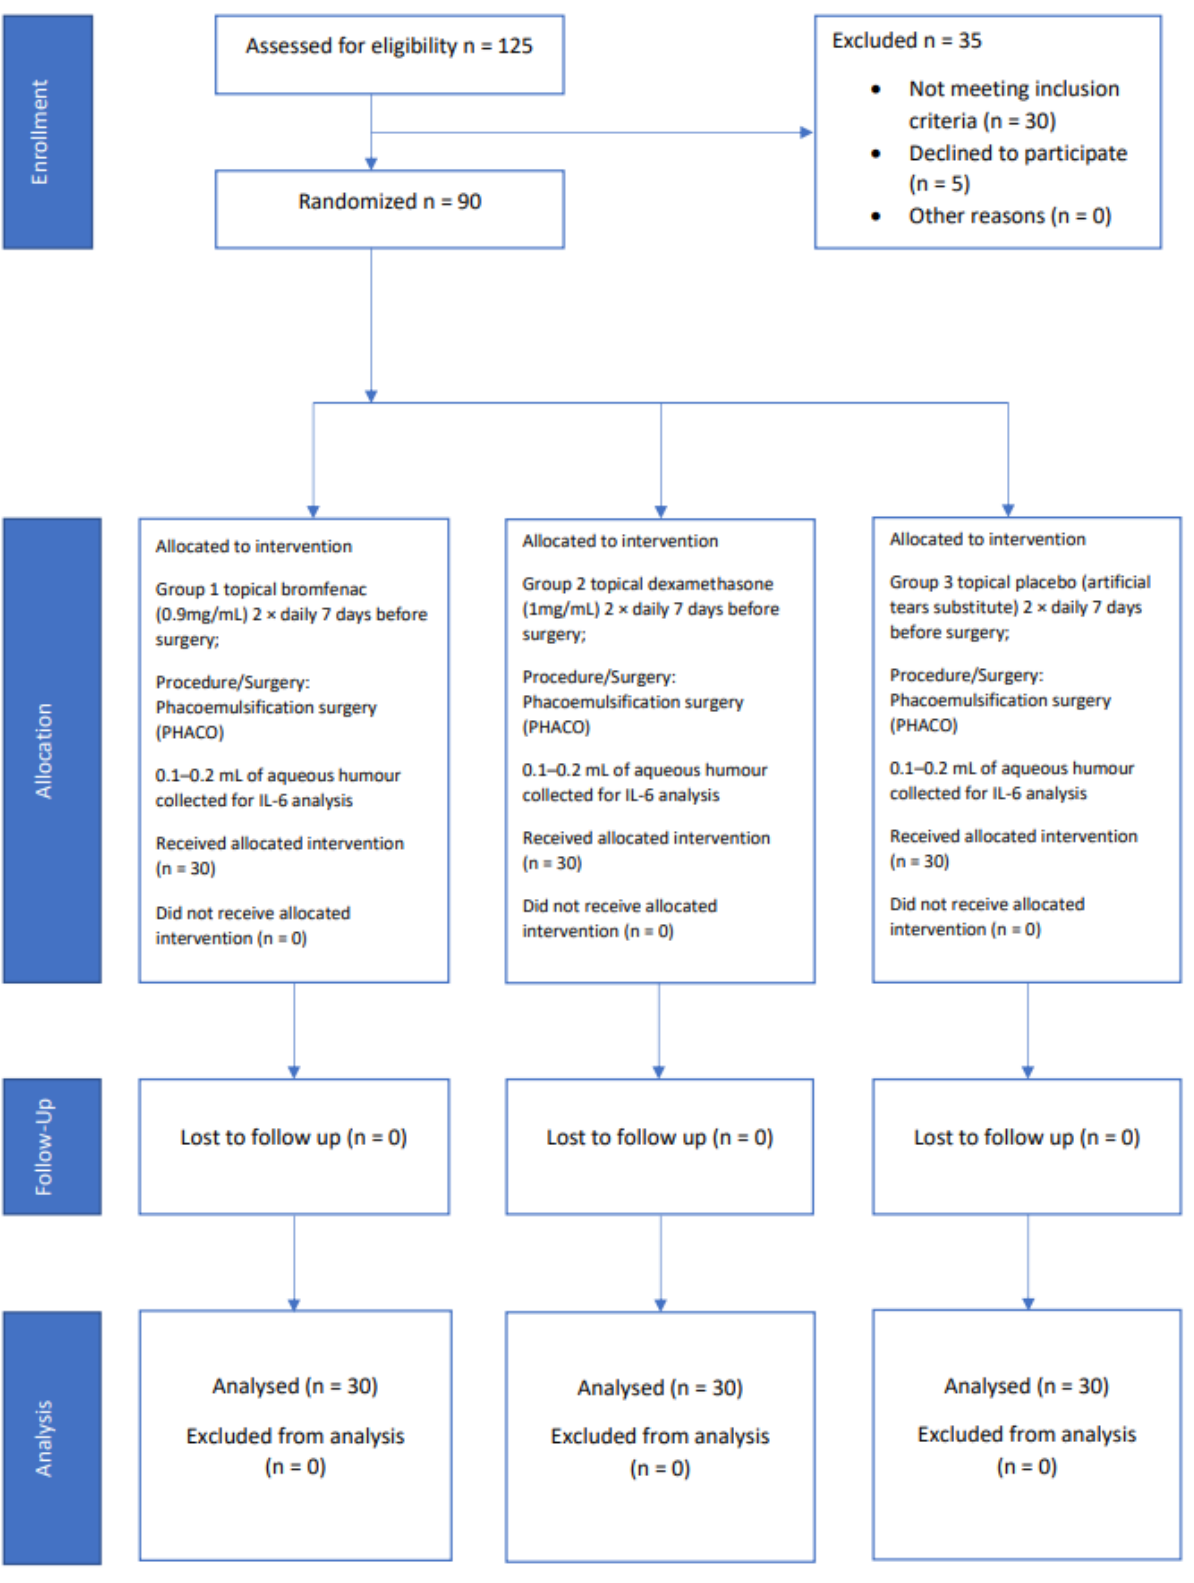
Figure 1. CONSORT flow diagram.